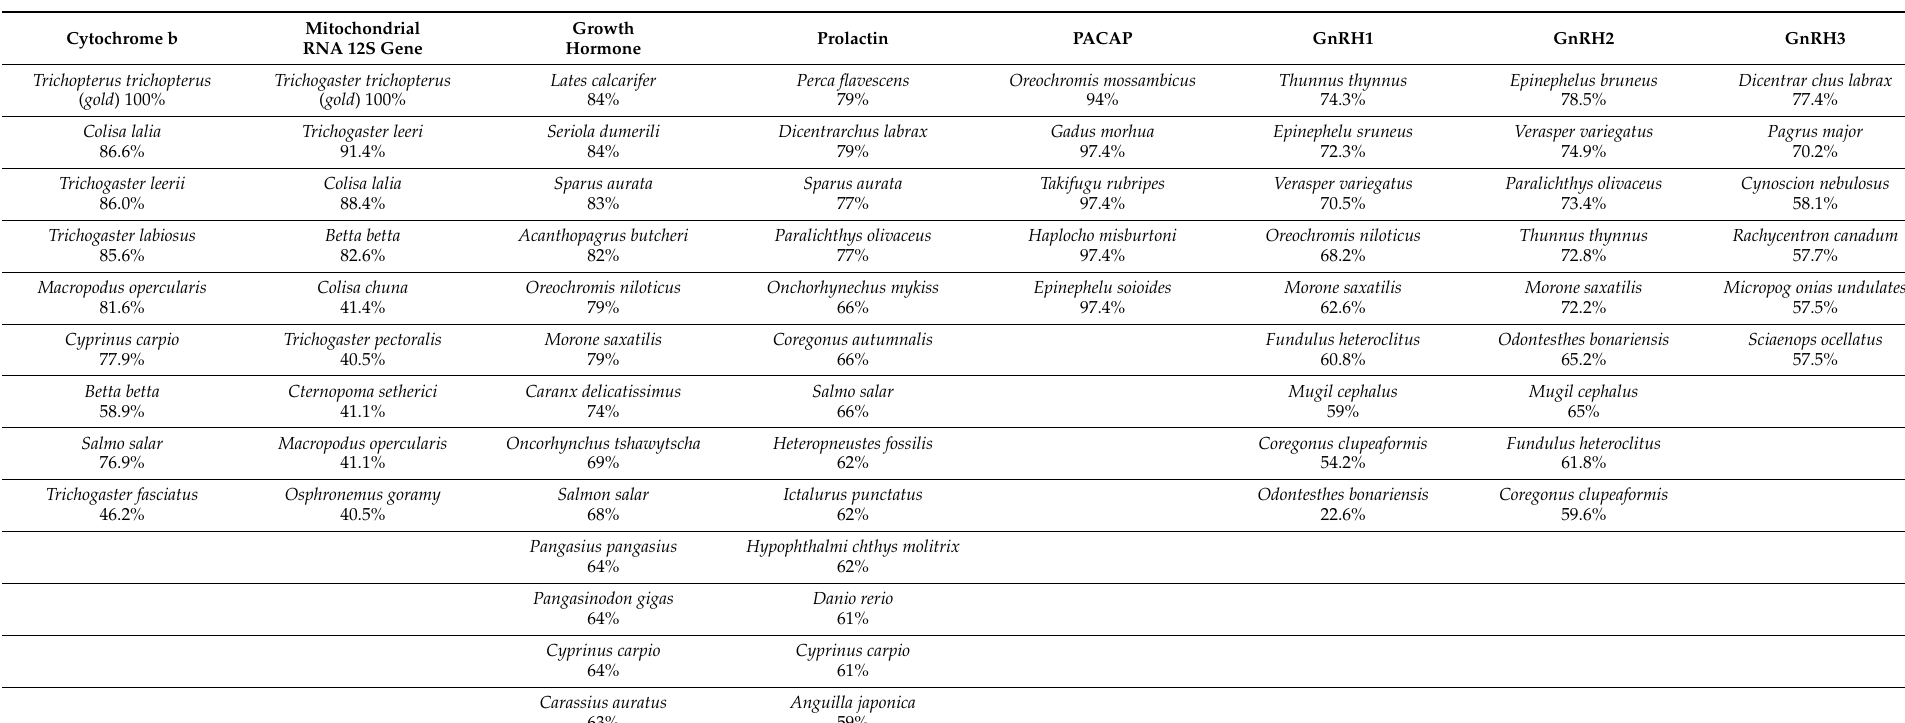
Table 3. Degree of nucleotide sequence similarity (%) of blue gourami ( Trichogaster trichopterus ) to different species